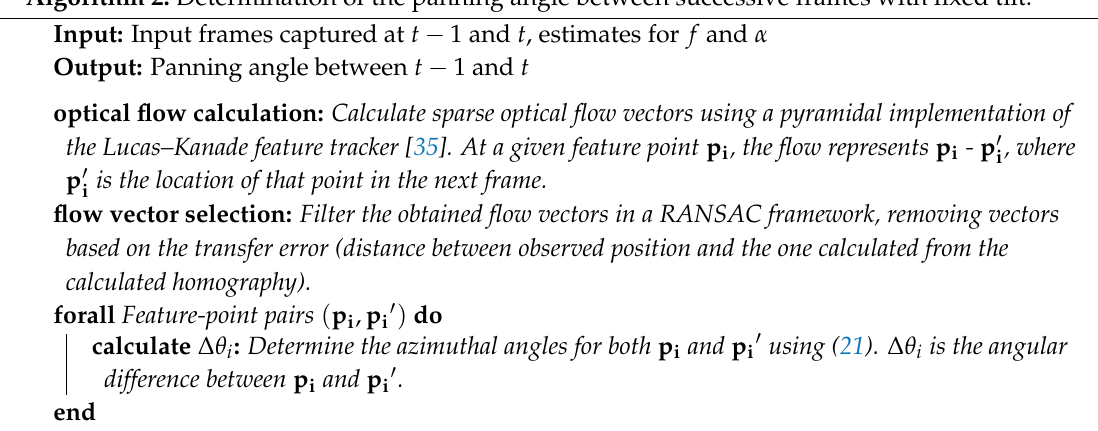
Algorithm 2: Determination of the panning angle between successive frames with fixed